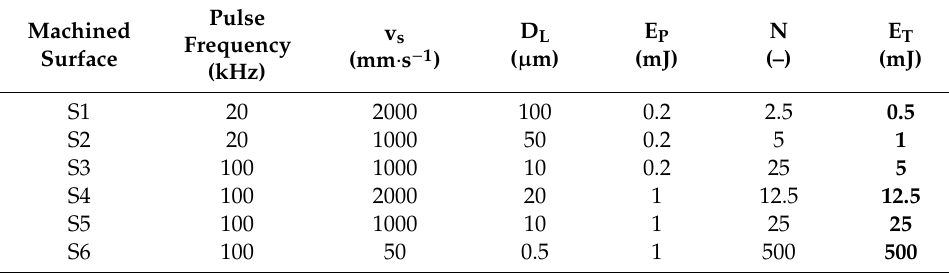
Table 1. Input process parameters of the laser-beam